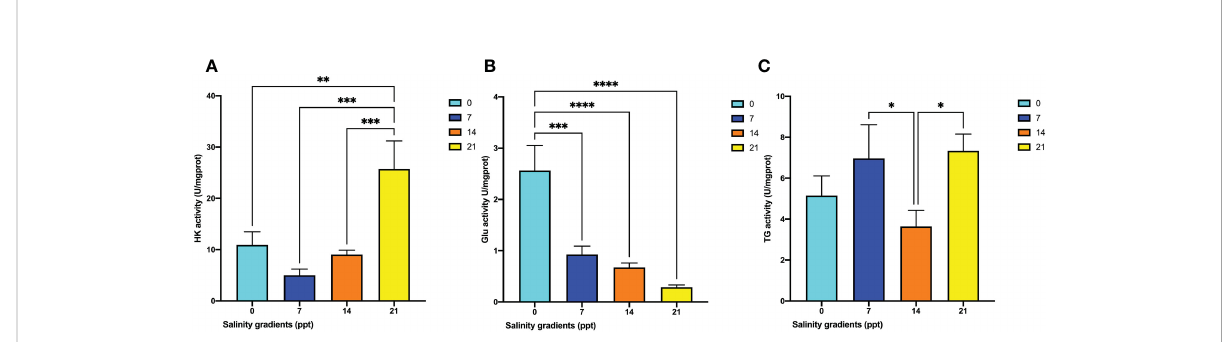
FIGURE 6 The changes of metabolism enzyme activities in the hepatopancreas of M. nipponense exposed to four salinity gradients. (A) HK; (B) Glu; (C) TG. * indicates the extent of signi fi cant difference (*: p < 0.05, **: p < 0.01, ***: p < 0.001, ****: p <